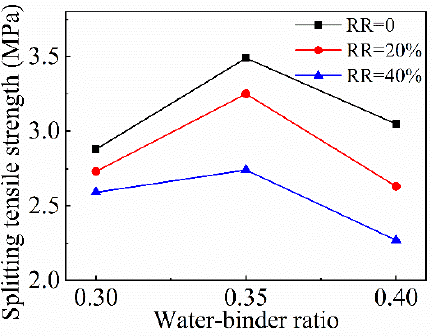
Figure 10. Variation of FRAC splitting tensile strength with w / b ratio.